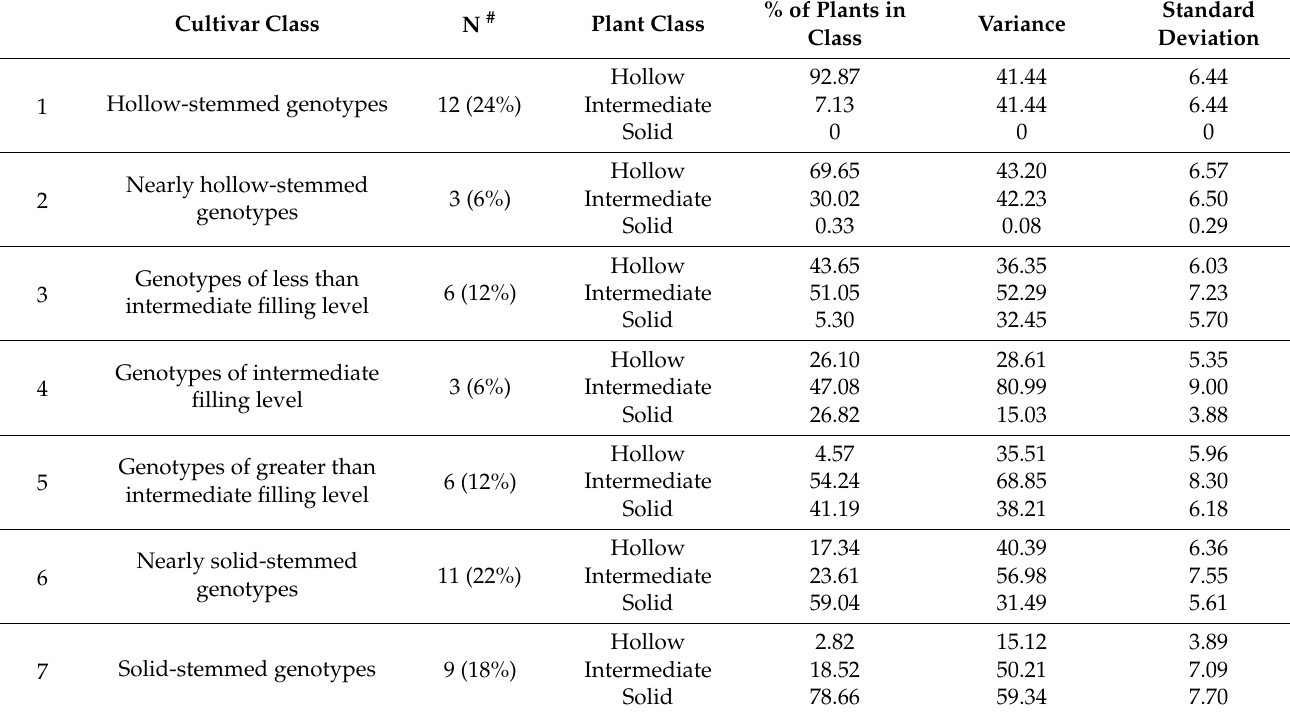
Table 4. Descriptive statistics for genotype classes of 50 spring wheat genotypes grouped with the Ward method. Cultivar